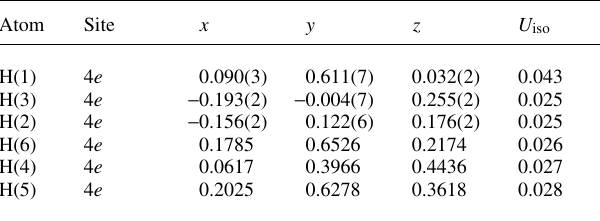
Table 2. Atomic coordinates and displacement parameters (in Å 2 )